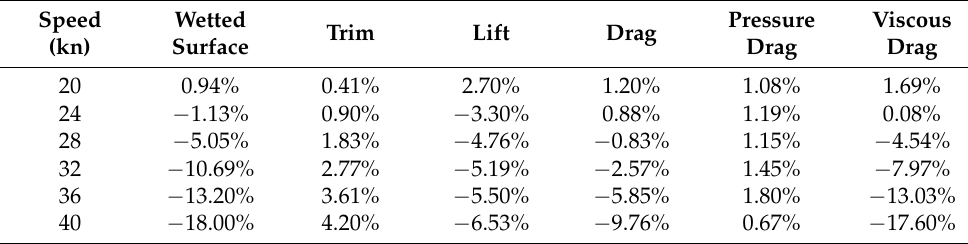
Table 17. Comparison of lift computed on SR.